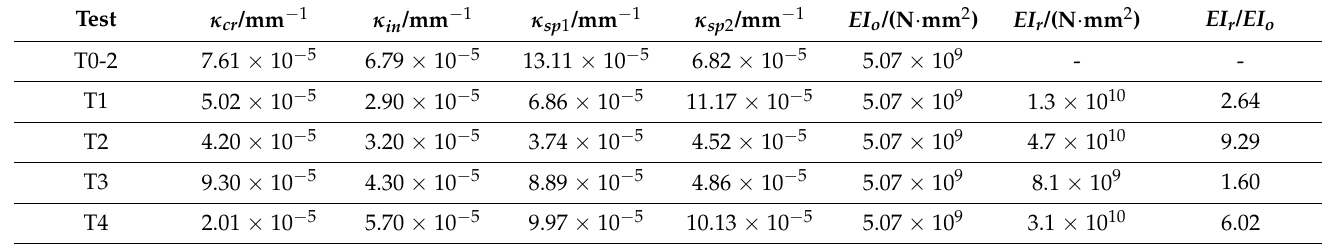
Table 3. Flexural rigidities of defective and partially rehabilitated